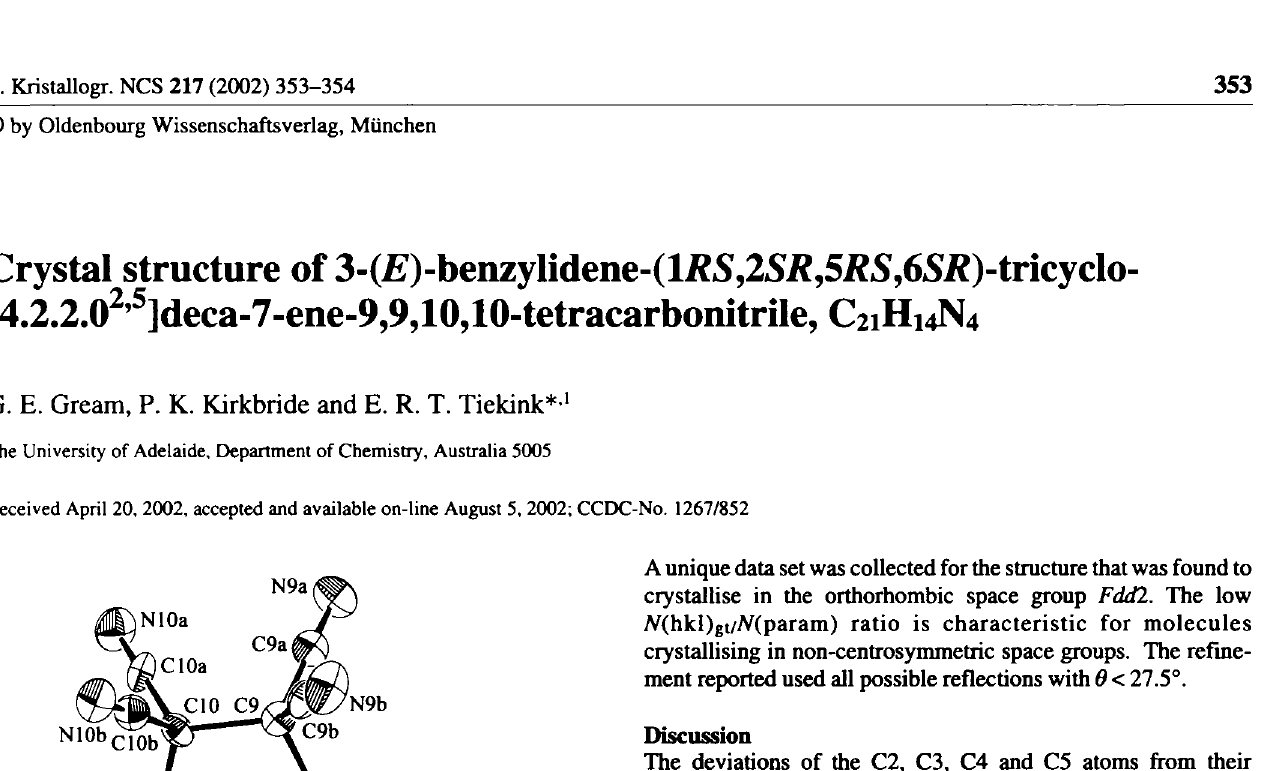
Table 1. Data collection and handling.